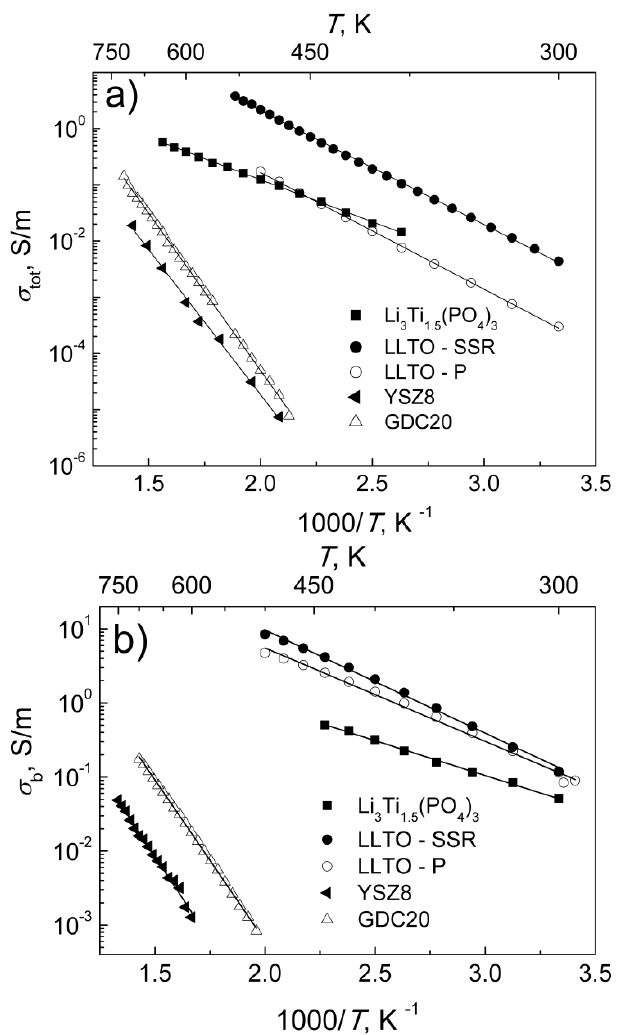
Figure 4: Temperature dependences total (a) and bulk (b) ionic conductivities of the investigated ceramics.